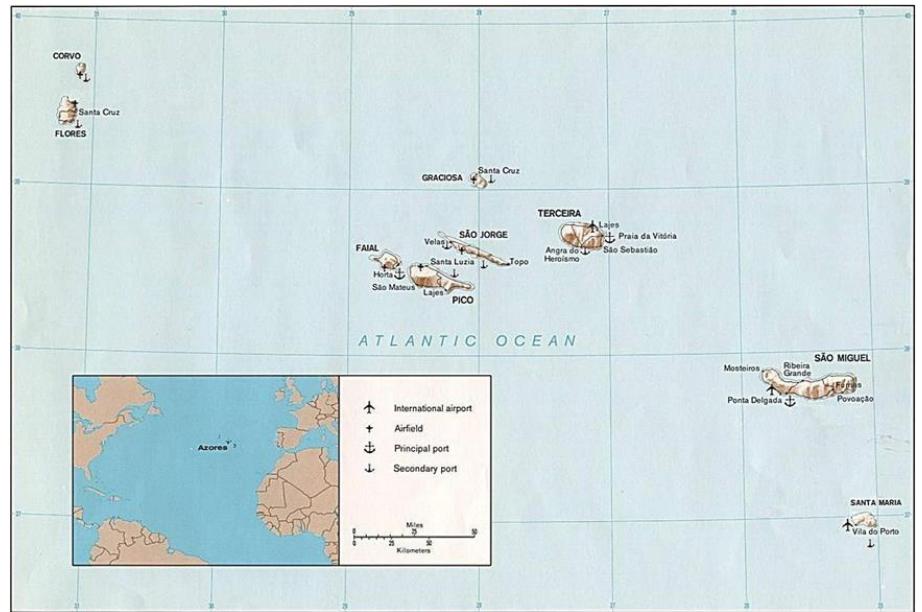
Figure 1. Azores Islands — geographical location [25].